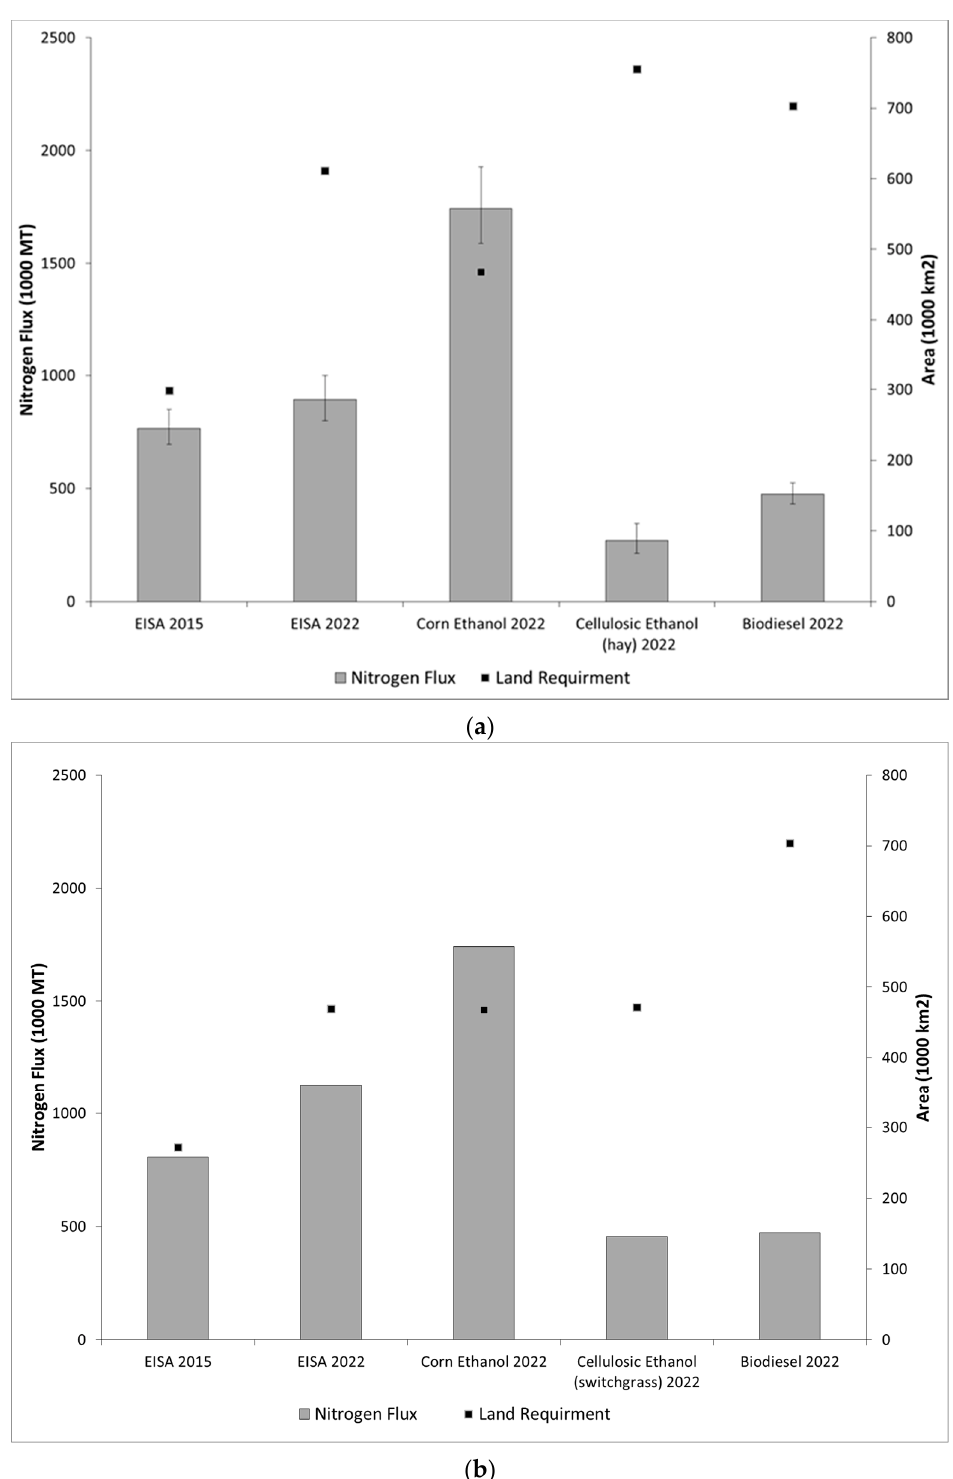
Figure 2. Total nitrogen flux and land requirements for different biofuels scenarios. Nitrogen fluxes using hay ( a ); nitrogen fluxes using switchgrass ( b ).